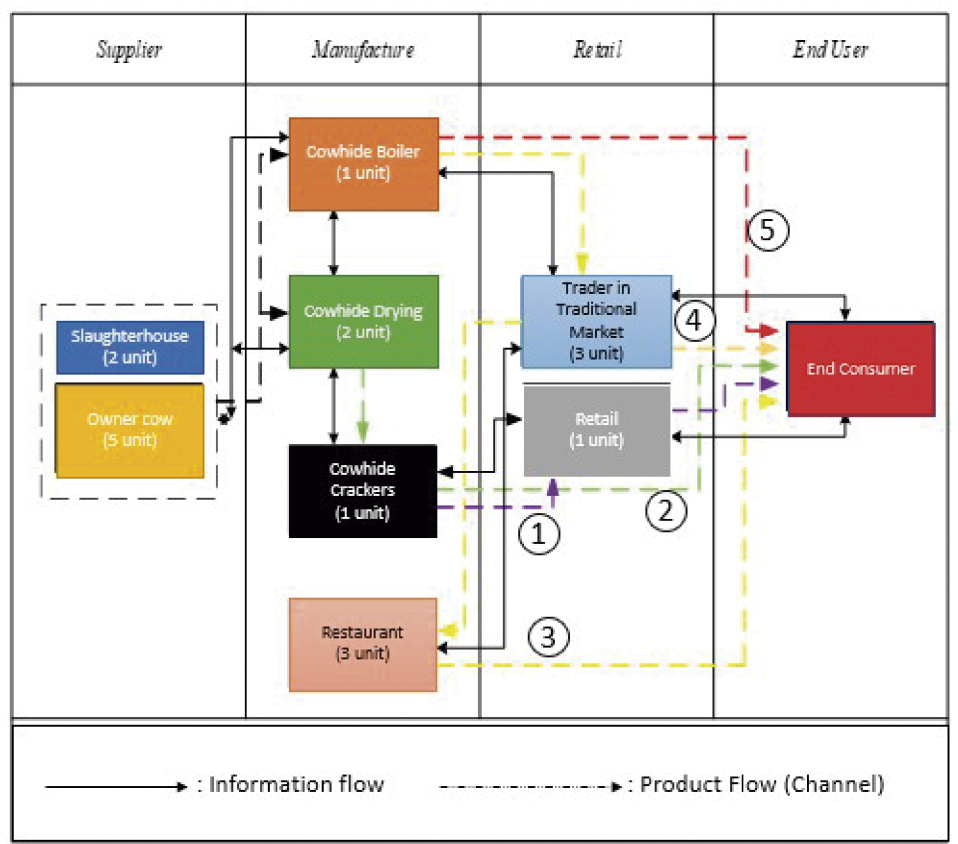
Figure 3. Food supply chain of distribution channel on cowhide